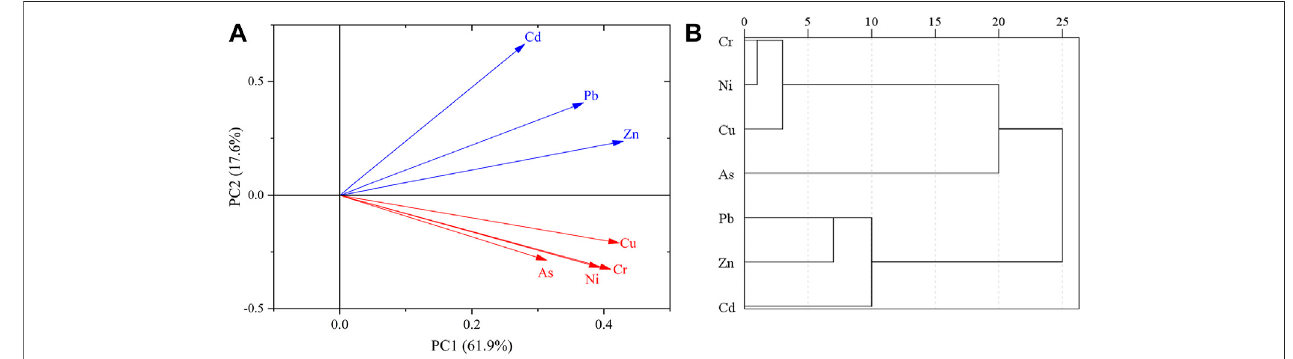
FIGURE 1 | Principal component analysis (A) and cluster analysis (B) for sources of HMs. Loadings larger than 0.50 are displayed in the principal component